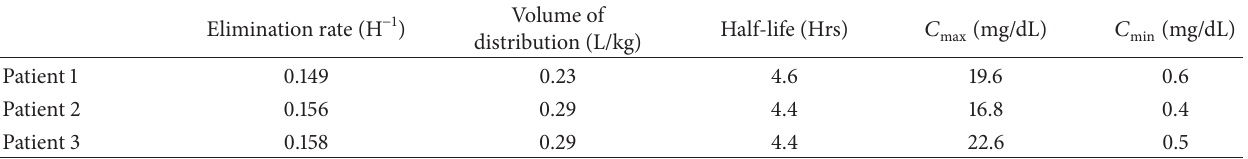
Table 3: Patient pharmacokinetic parameters when two concentrations were